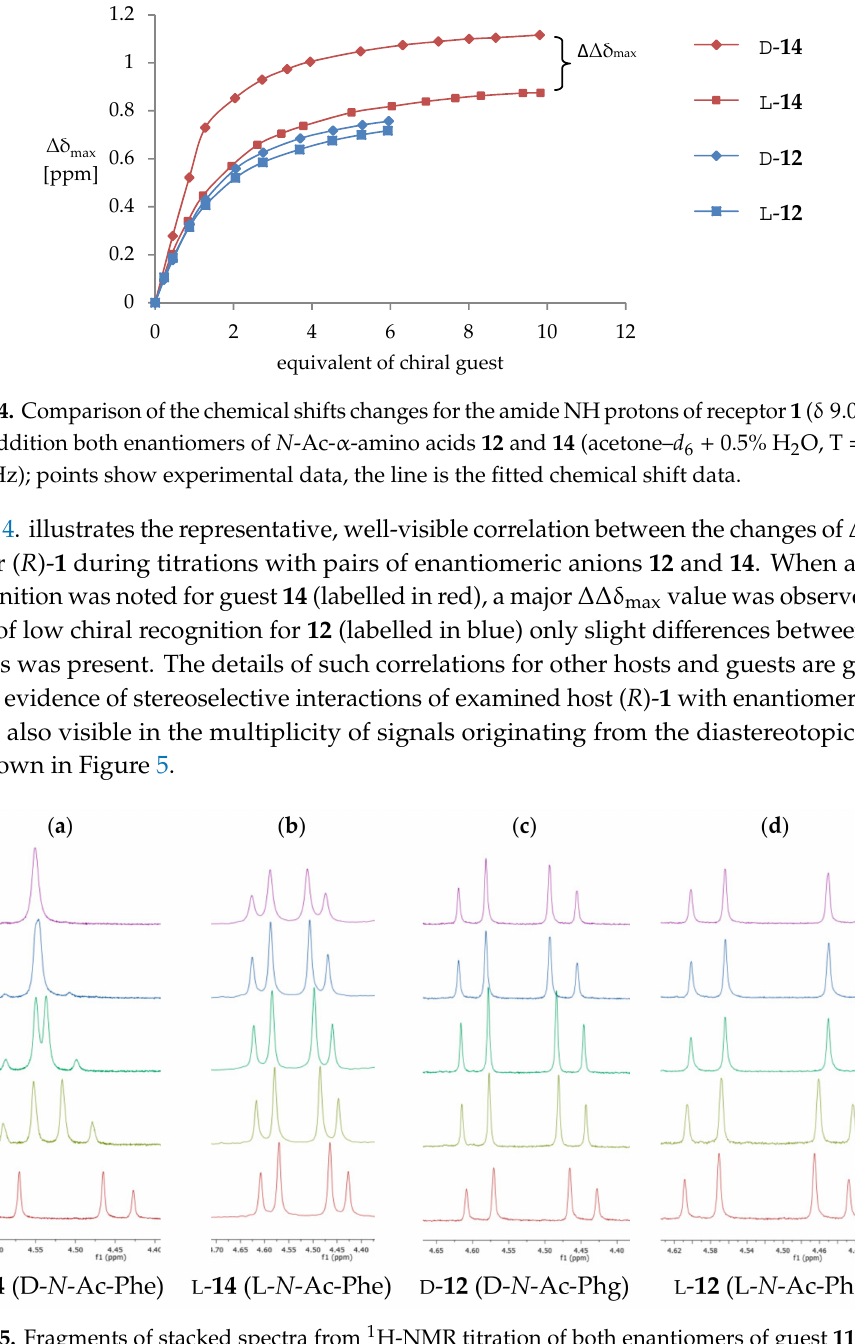
Figure 5. Fragments of stacked spectra from 1 H-NMR titration of both enantiomers of guest 11 and 12 with host ( R )- 1 (acetone– d 6 + 0.5% H 2 O, T = 298 K, 400